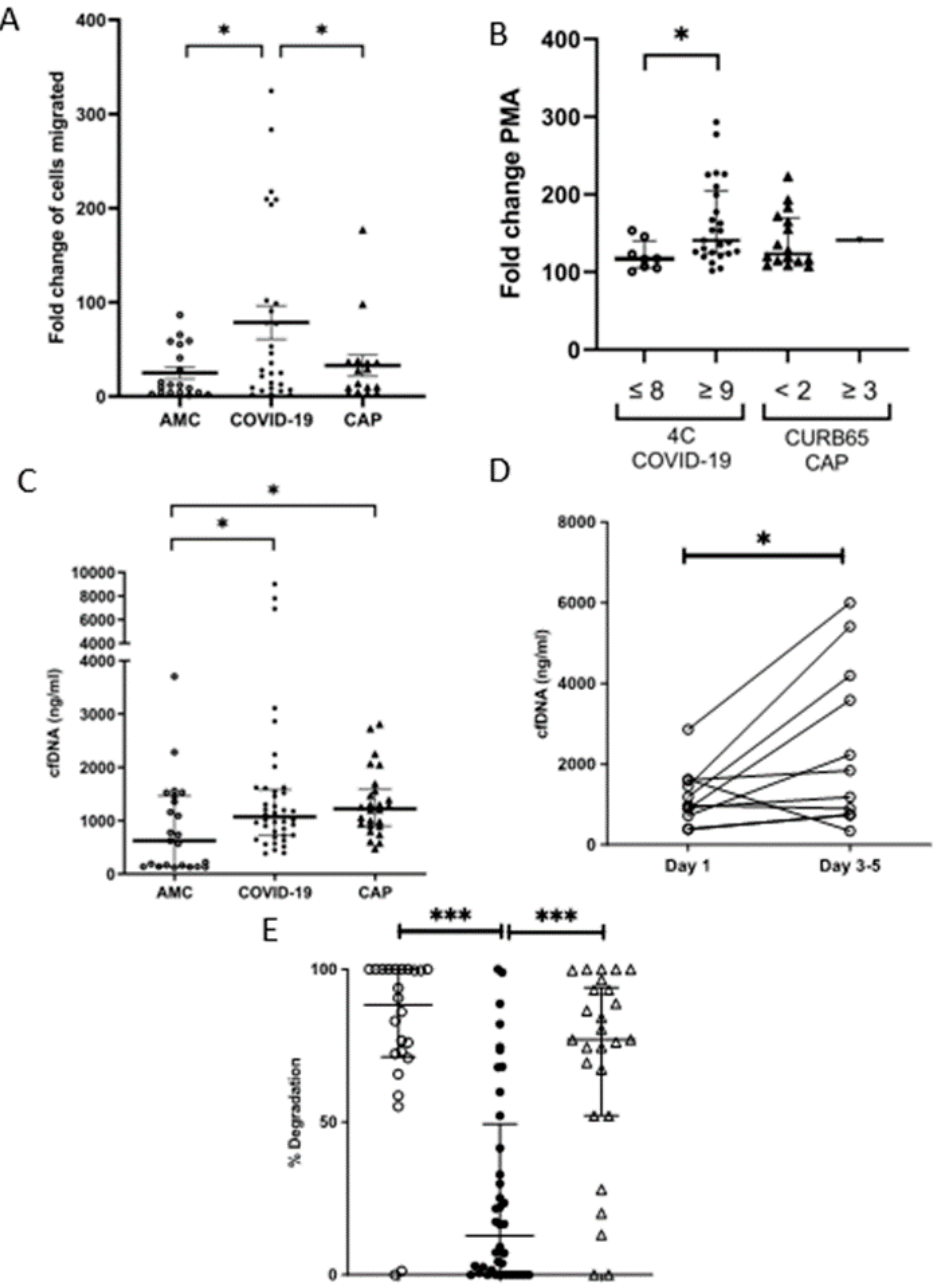
Figure 3. NETosis in COVID-19. ( A ) NET release by neutrophils stimulated with PMA for 3 h, measured as the absorbance of cfDNA stained with Sytox green. Data shows a fold change in absorbance of PMA stimulated neutrophils compared to vehicle control. * p = 0.0394 AMC (n = 26) vs. COVID-19 (n = 33), CAP (n = 17). ( B ) Comparison of NET release by activated neutrophils in patients with low 4C (n = 8) or high 4C (n = 26) score, * p = 0.0118. There was no difference between CAP patients differentiated by curb65 score. ( C ) Plasma cell free DNA levels measured by fluorometry in AMC * p = 0.0396 AMC (n = 23) vs. COVID-19 (n = 39), * p = 0.0322 AMC vs. CAP (n = 26). ( D ) Comparison of cfDNA levels measured by fluorometry in COVID-19 (n = 10) on day one and on days three to five. * p = 0.0186. ( E ) % DNA degradation by serum NETs. *** p < 0.0001 AMC (n = 24) vs. COVID-19 (n = 40), *** p = 0.0001 AMC vs. CAP (n = 26).